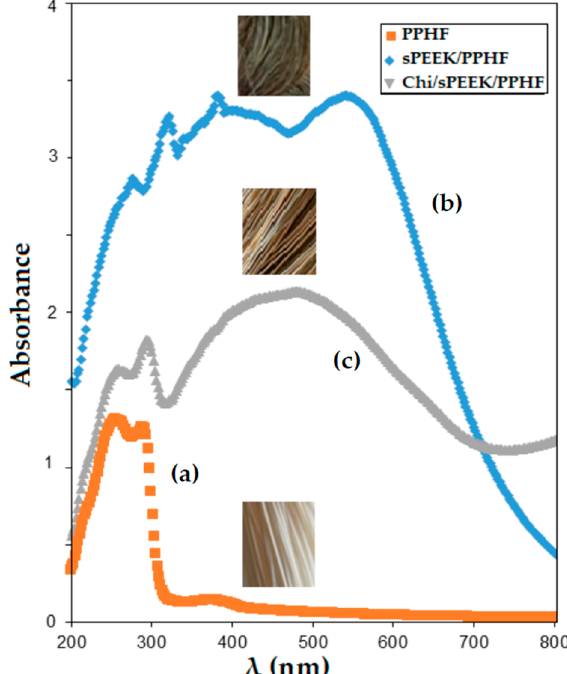
Figure 8. UV-Vis spectrometry on ( a ) polypropylene hollow-fiber membrane (PPHF); ( b ) sulfonated poly (ether ether ketone) (sPEEK)-polypropylene hollow fiber (sPEEK/PPHF); and ( c ) chitosan (Chi)–sulfonated poly (ether ether ketone) (sPEEK)–polypropylene hollow fiber (Chi/sPEEK/PPHF).